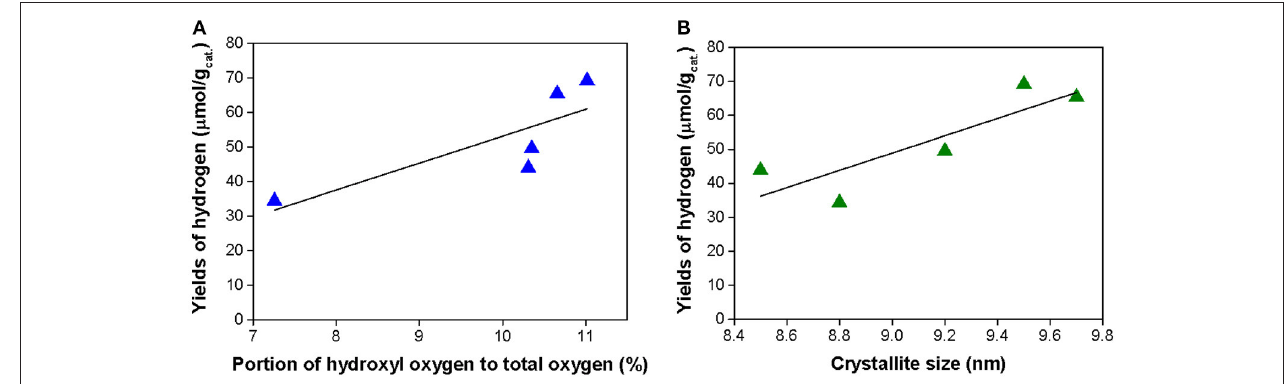
FIGURE 9 | Correlation between the yield of hydrogen in the CH 3 OH photocatalytic oxidation and content of lattice oxygen to sum of oxygen (A) and crystallite size (B)